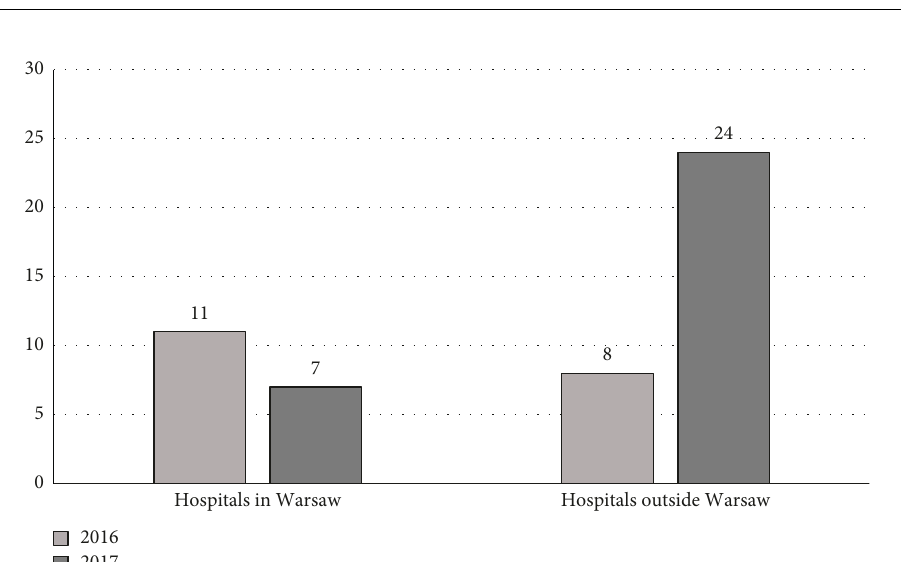
Figure 3: Number of epidemic outbreaks of symptomatic infections with NDM-producing Klebsiella pneumoniae in hospitals in the Mazovian Voivodeship in